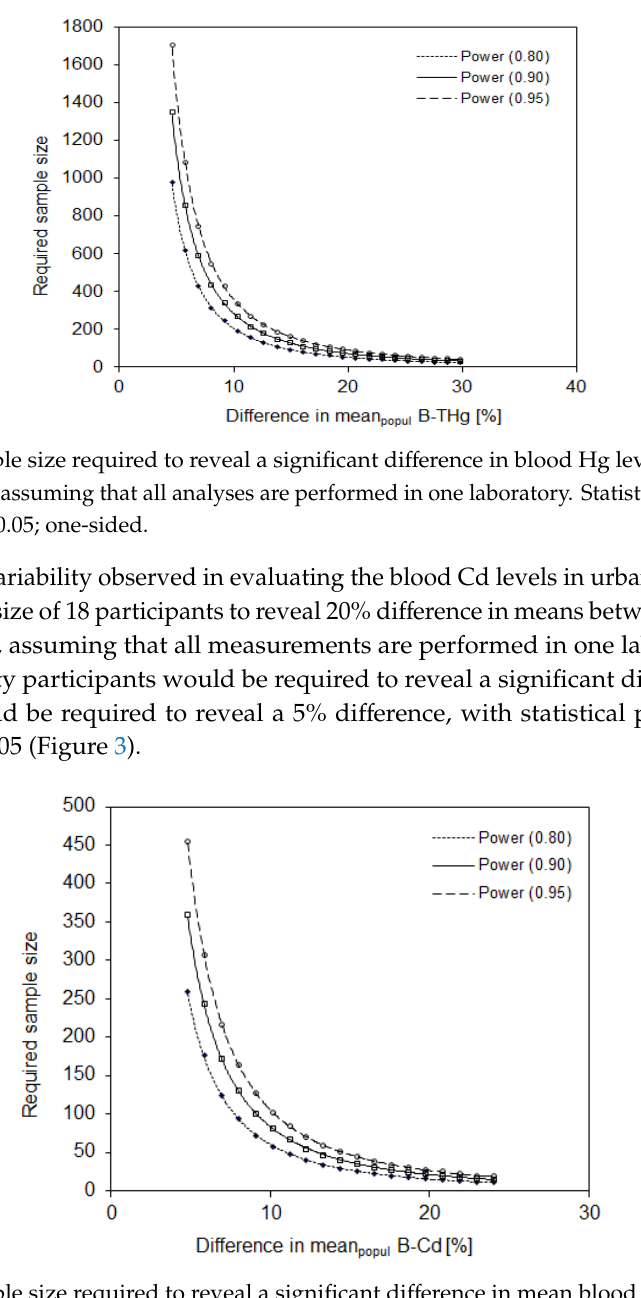
Figure 3. The sample size required to reveal a significant difference in mean blood Cd between two population groups, assuming that all analyses are performed in one laboratory. Statistical power = 0.80, 0.90, and 0.95; α = 0.05; one-sided.